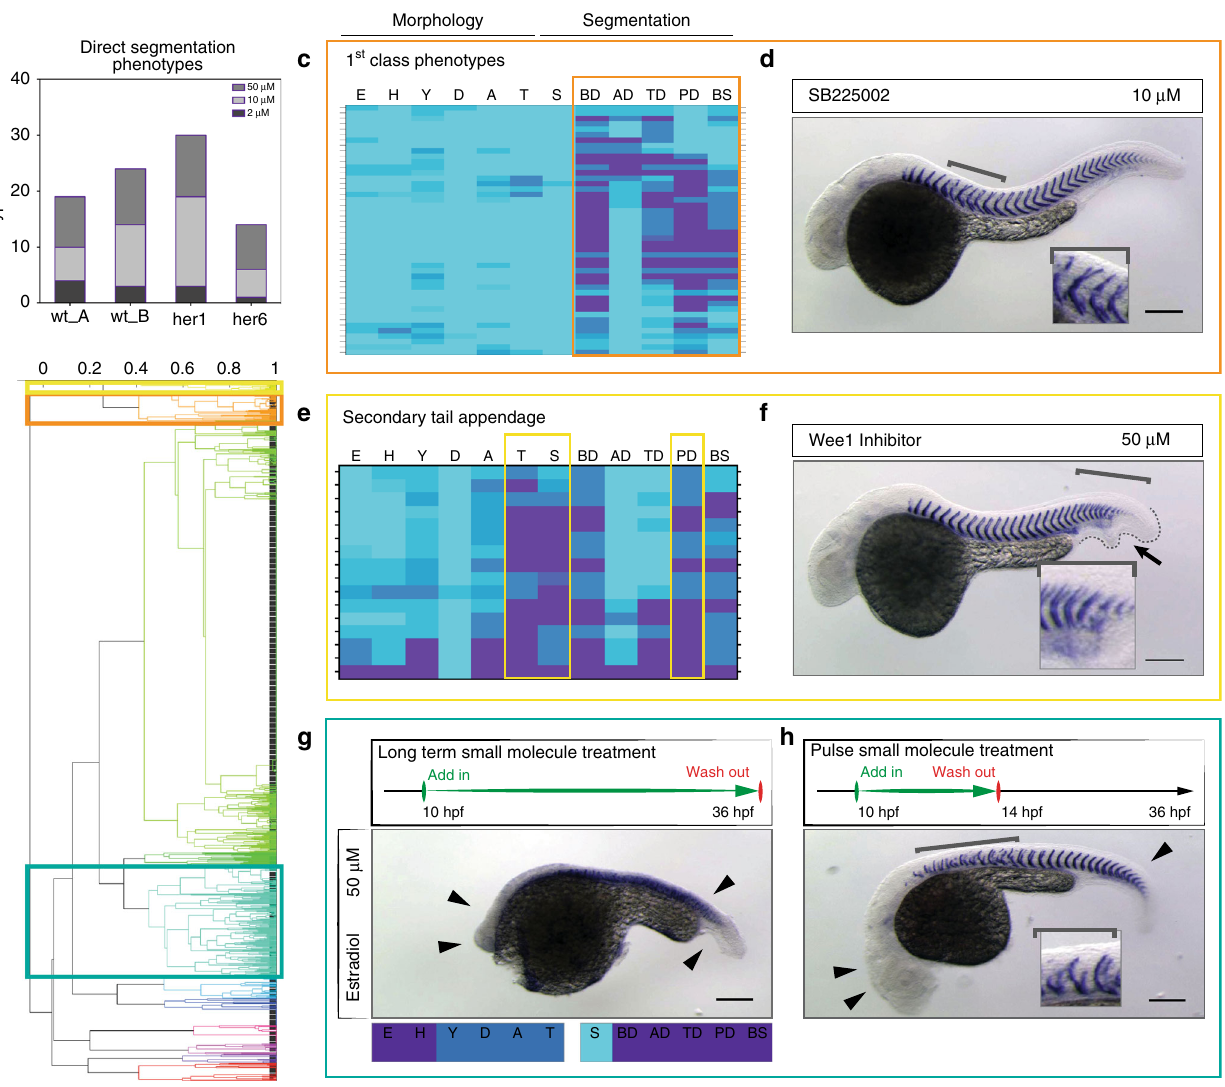
Fig. 2 Phenotypic hit selection. a Number of direct segmentation phenotypes in each experiment identi fi ed as hits. The same small molecules may count multiple times, if phenotypes were observed in more than one treatment. b Dendrogram from hierarchical cluster analysis of phenotypic vectors. Colored boxes highlight clusters presented in c , e , g ; high-resolution dendrogram in Supplementary Fig. 1. Correlation values above plot. c Direct segmentation phenotypes identi fi ed as “ 1st class phenotypes ” , obtained from fi ve different small molecules. d 10 µ M SB225002 in wild type embryos caused speci fi c mid-trunk defects of myotome boundaries (brackets, inset) with normal embryo morphology. e Direct segmentation phenotypes identi fi ed as “ secondary tail appendage ” . f 50 µ M Wee1 Inhibitor in wild type embryos showing relatively normal morphology, but posterior segmentation defects (brackets, inset) with a small secondary tail appendage (arrow, dotted line). g , h Molecules were selected from cluster with segmentation defects and strong morphological defects. Temporally-controlled pulse in wild type embryos increased segmentation-speci fi city. g Standard long-term small molecule treatment with 50 µ M estradiol caused strong developmental defects with rudimentary head and axis in wild type embryos (arrowheads). h Pulse experiments of 50 µ M estradiol from 10 hpf for four hours showed recovered head and axis structures (arrowheads) and speci fi c myotome boundary disruptions of up to 13 segments (bracket). Inset shows disrupted boundaries. Wild type embryos at 36 hpf, in situ hybridization for xirp2a . Scale bar: 200 µ